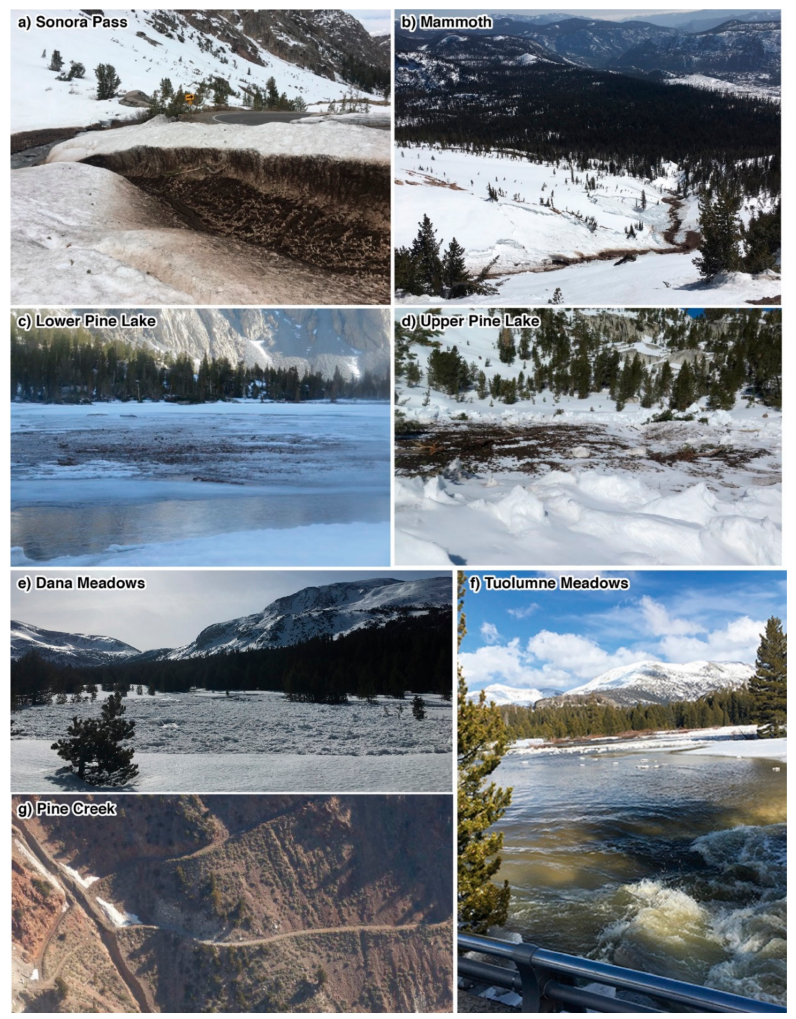
Figure 6. High elevation hydrogeomorphological impacts of the 5–7 April atmospheric river. ( a ) Deadman Creek near Sonora Pass (2698 m); ( b ) Fresno Bowl avalanche near Mammoth, California (3000 m); ( c ) Deposition of debris onto Lower Pine Lake (3032 m); ( d ) Deposition of debris onto Upper Pine Lake (3109 m); ( e ) Flooding of Dana Meadow (2962 m); ( f ) Flooding of the Tuolumne River in Tuolumne Meadows (2626 m); ( g ) Pine Creek mining road cut by debris chute (~2700